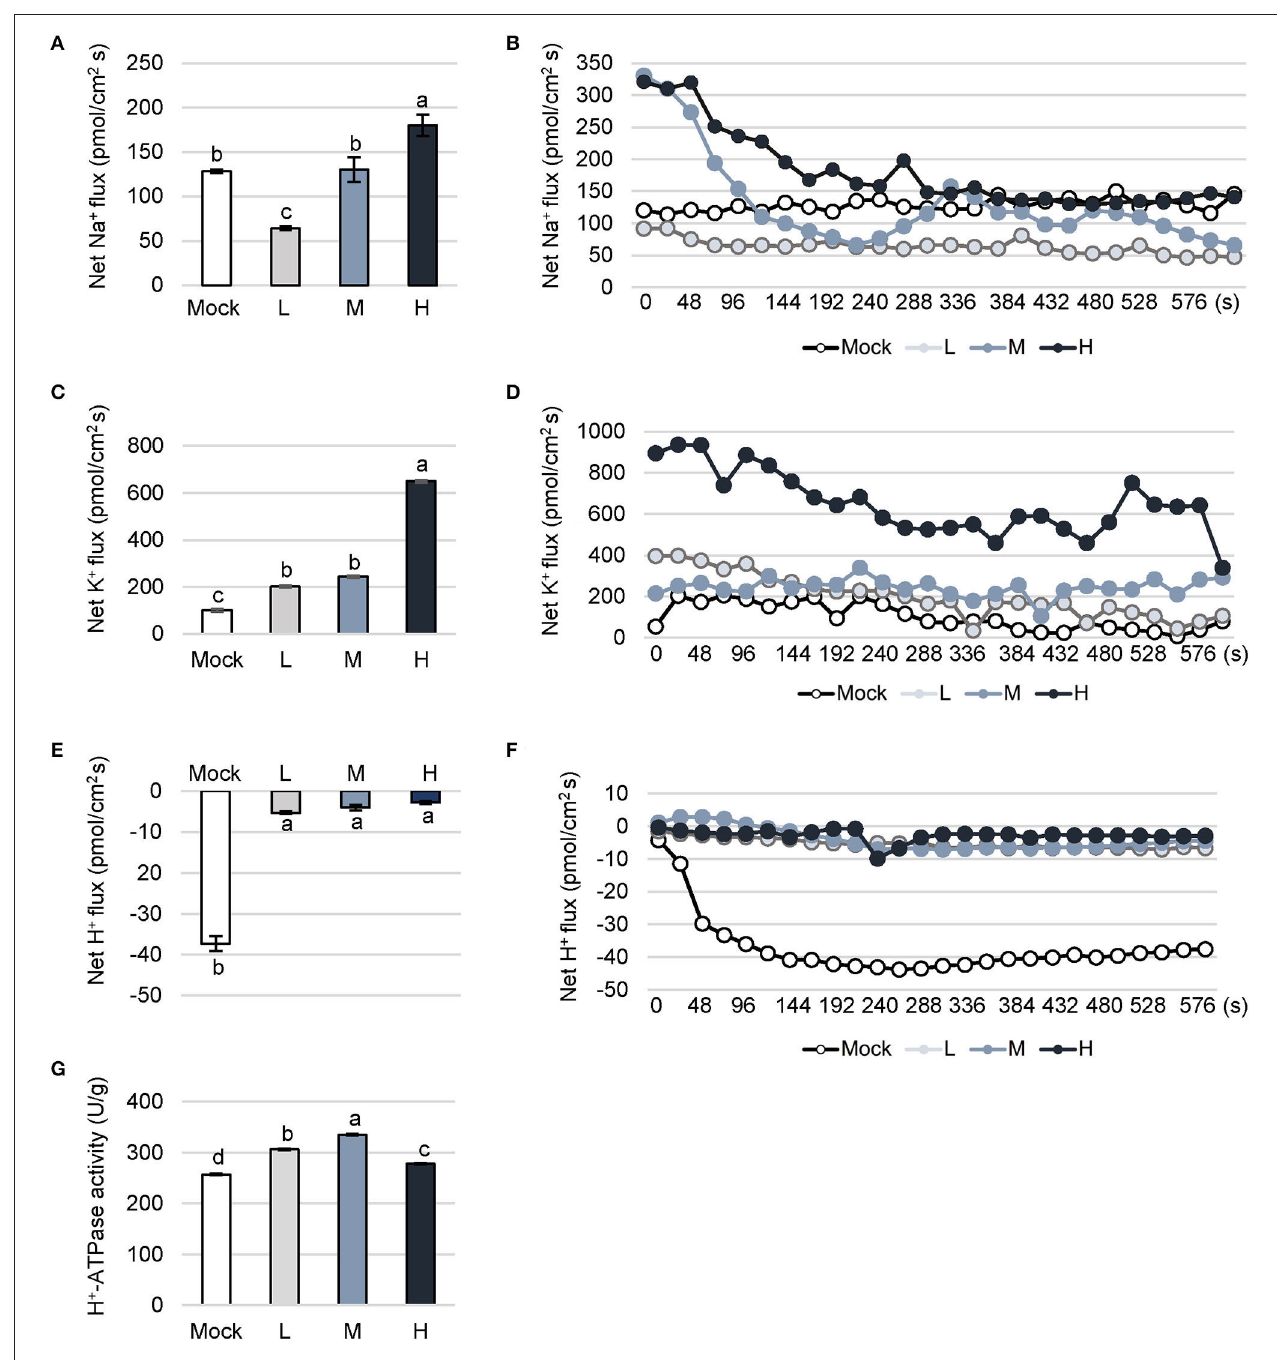
FIGURE 4 | Dynamic fluctuation of cation flow under different levels of salt stress. Na + (A,B) , K + (C,D) and H + (E,F) flux and activity of H + -ATPase (G) in C. inerme leaves were detected on day 14 under different saline stress. Different letters indicate significant differences among plant groups ( p < 0.05, Mann Whitney test). Mock, no salt control; L, low salt stress; M, medium salt stress; H, high salt stress.